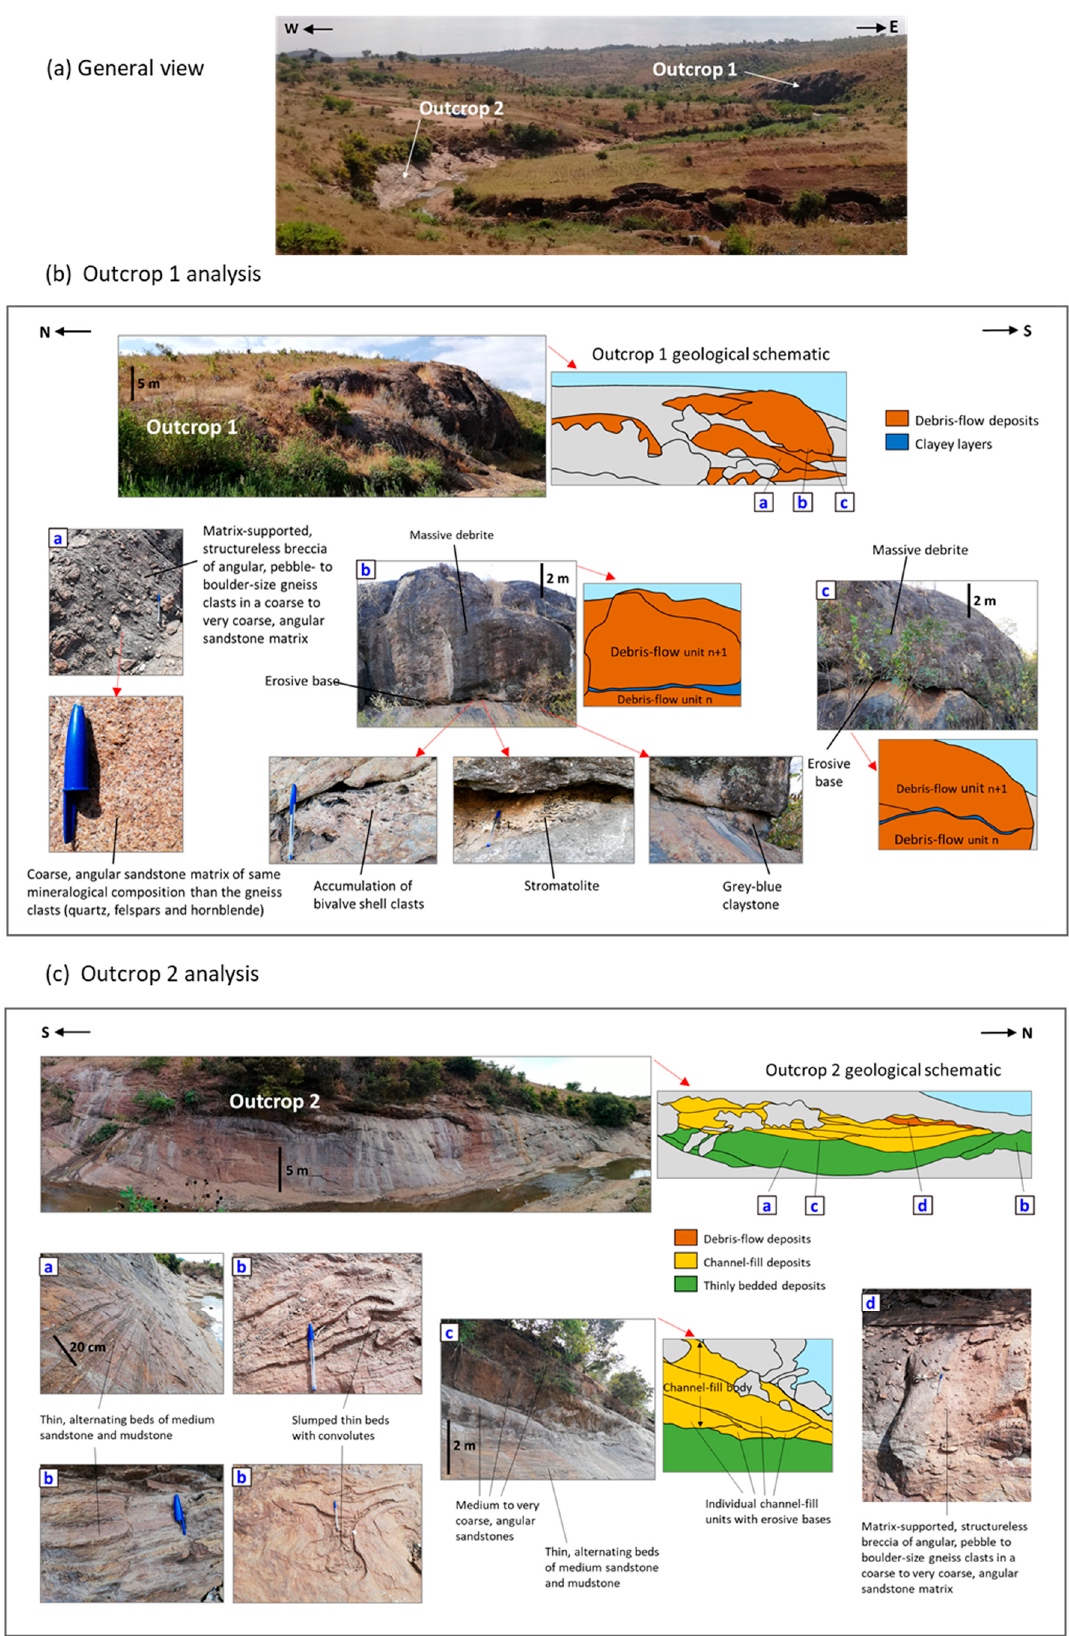
Figure 10. Chiluwe outcrop analyses: ( a ) general view of outcrops, ( b ) Outcrop 1 analysis and ( c ) Outcrop 2 analysis. The locations of letter-labelled photo are marked on the geological schematic of the main outcrop photo.